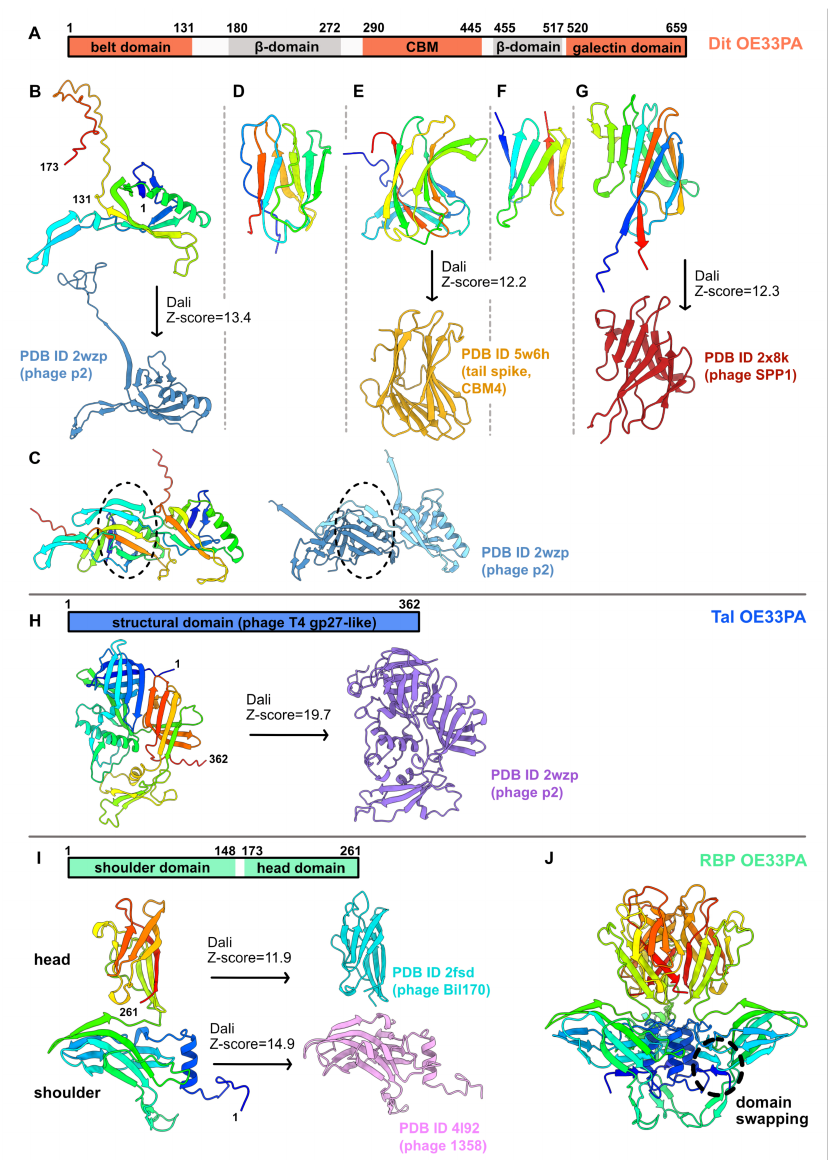
Figure 2. AlphaFold2 structure predictions for OE33PA Dit, Tal, and RBP. ( A – G ) Dit of OE33PA. ( A ) Dit domain organization. Domains with structural homologs are shown in salmon, while do- mains with unknown folds are shown in grey. The domain boundaries predicted by AlphaFold2 are indicated. ( B ) Ribbon representations of the predicted belt and putative ‘arm’ structure (rainbow) and of the phage p2 Dit belt–arm domain (steel blue). ( C ) Comparison of the Dit dimeric assembly predicted by AlphaFold2 (rainbow) and a p2 Dit dimeric assembly determined by X-ray crystallogra- phy (steel bleu). Dotted ovals highlight intermolecular contacts. ( D ) Ribbon representation of the predicted β -domain (rainbow). This structure did not return significant hits with Dali. ( E ) Ribbon representations of the predicted CBM (rainbow) and the C-terminal domain of a phage tail spike (gold). ( F ) Ribbon representation of the predicted β -domain (rainbow). This structure did not return significant hits with Dali. ( G ) Ribbon representations of the predicted galectin structure (rainbow) and the phage SPP1 Dit galectin domain (red). ( H ) (Top) Tal domain organization. (Bottom) Ribbon representations of the predicted Tal structure (rainbow) and the phage p2 Tal structural domain (purple). ( I ) (Top) RBP domain organization. (Bottom) Ribbon representations of the predicted RBP structure (rainbow), the phage Bil170 RBP head domain (pink), and the phage 1358 RBP shoulder domain (light blue). ( J ) Ribbon representations of the AlphaFold2 RBP trimeric assembly. The dotted oval highlights shoulder domain